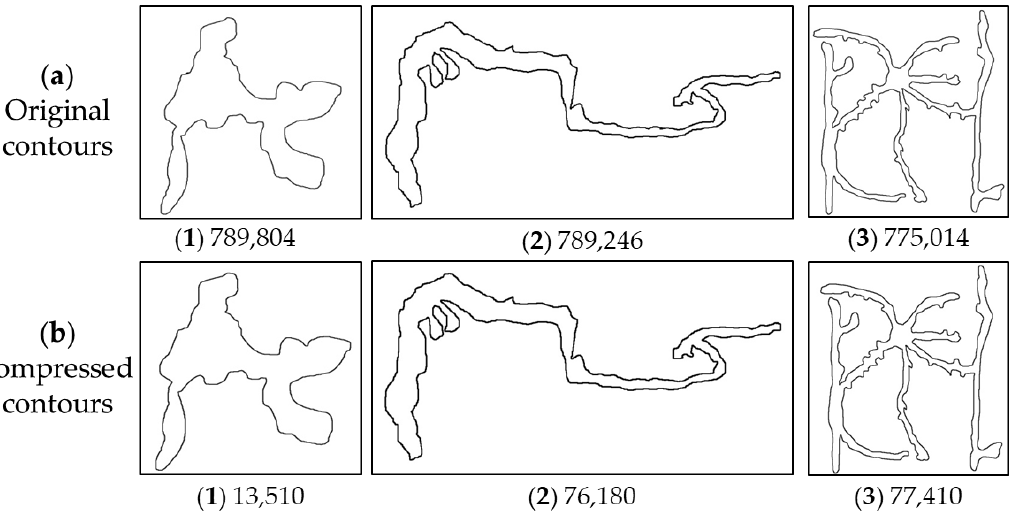
Figure 3. The effect of compression using the DP algorithm: row ( a ) represents the original contour after manual extraction. The ( a ) ( 1 ) contour has 789,804 points; the ( a ) ( 2 ) contour has 789,246 points; and the ( a ) ( 3 ) contour has 775,014 points. Row ( b ) indicates the contours after compression using the DP algorithm. The ( b ) ( 1 ) contour has 13,510 points; the ( b ) ( 2 ) contour has 76,180 points; and the ( b ) ( 3 ) contour has 77,410 points.